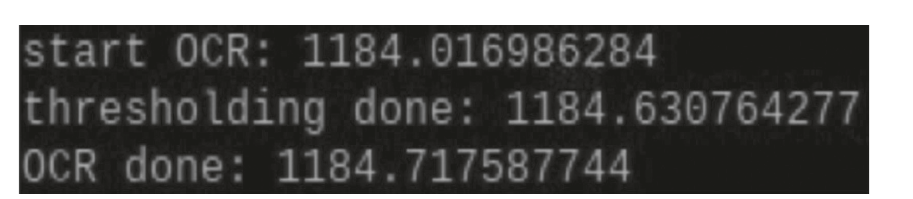
Figure 12: Required computation time for processing an